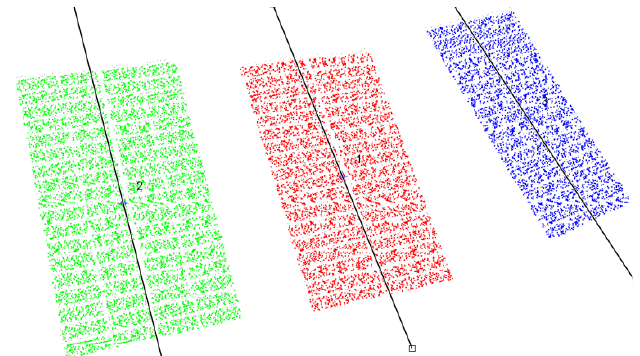
Figure 14. Principal component of each module (situation in which there is a horizontal fault in the tracker of the right PV module).